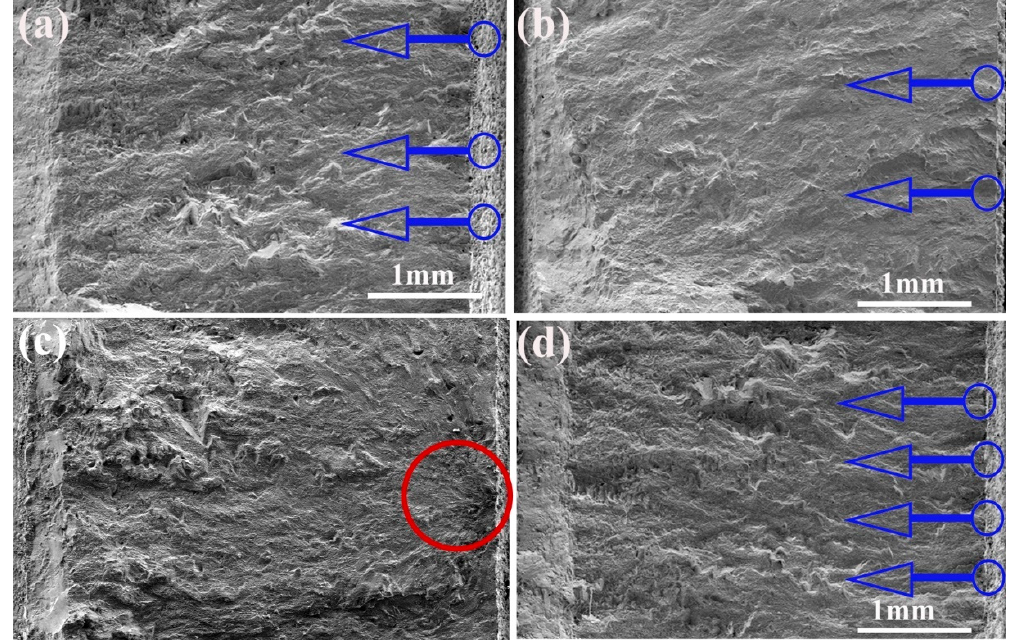
Figure 8. Fracture surfaces: ( a ) the as-received sample, ( b ) the LP-1 sample, ( c ) the LP-2 sample, and ( d ) the LP-3 sample. (Blue arrows show crack initiation sites, and red circle shows defects).